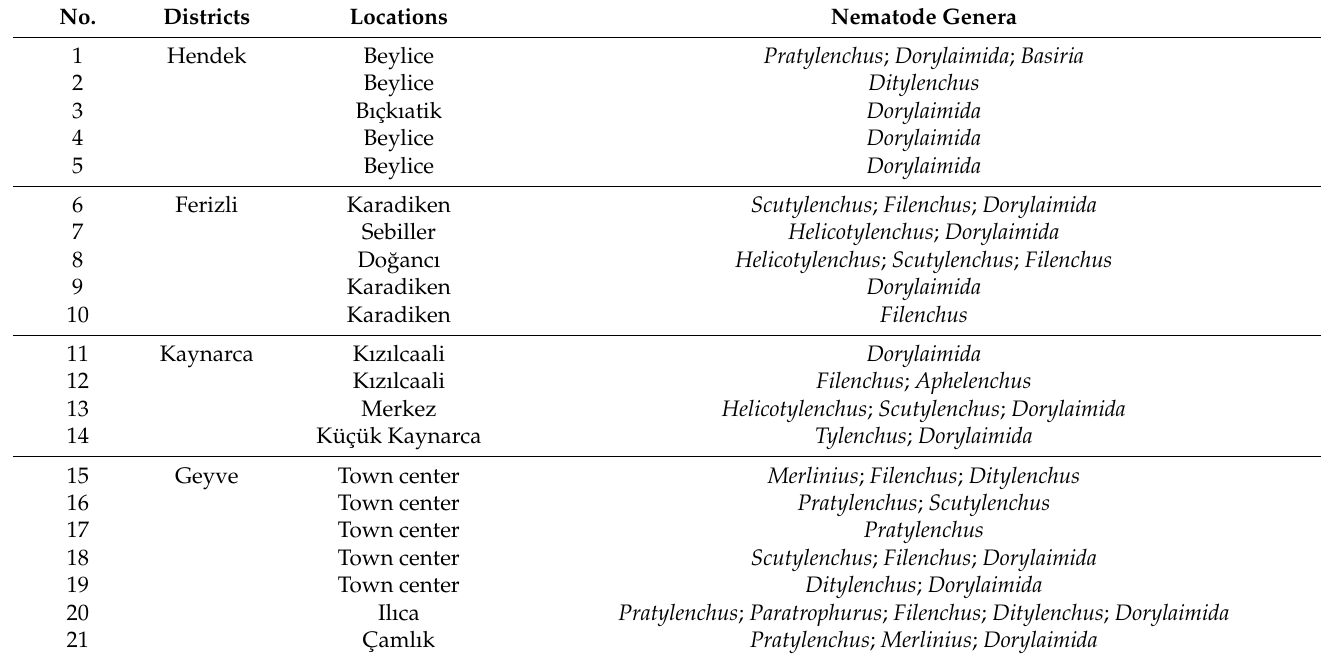
Table 2. The plant-parasitic nematodes surveyed wheat areas in Sakarya